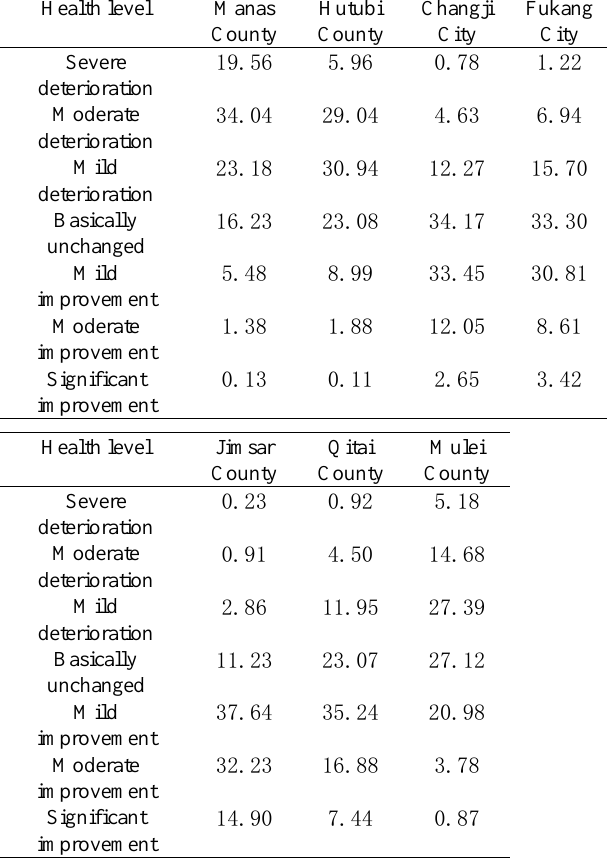
ioration of 5.16%, moderate deterioration of 14.53, and mild det Table 5. Statistical analysis on the result of grassland health erioration of 18.73%. The deterioration of grassland health statu trends in Changji Prefecture counties and cities between 2000 s was slightly greater than improvement. In the region, the overa and 2016 unite:% ll trend is slightly declining; According to the statistical data of counties and cities under the jurisdiction of the city, the grasslan d health in Changji, Fukang, Jimsar County, and Qitai counties has improved, and in Manas and Hutubi counties. The grassland health condition in Mulei County has been deteriorating. Throu gh comparative analysis, the grassland health status in Changji Prefecture has shown a slight downward trend, but more attenti on needs to be paid to prevent further degradation of the grassla nd health